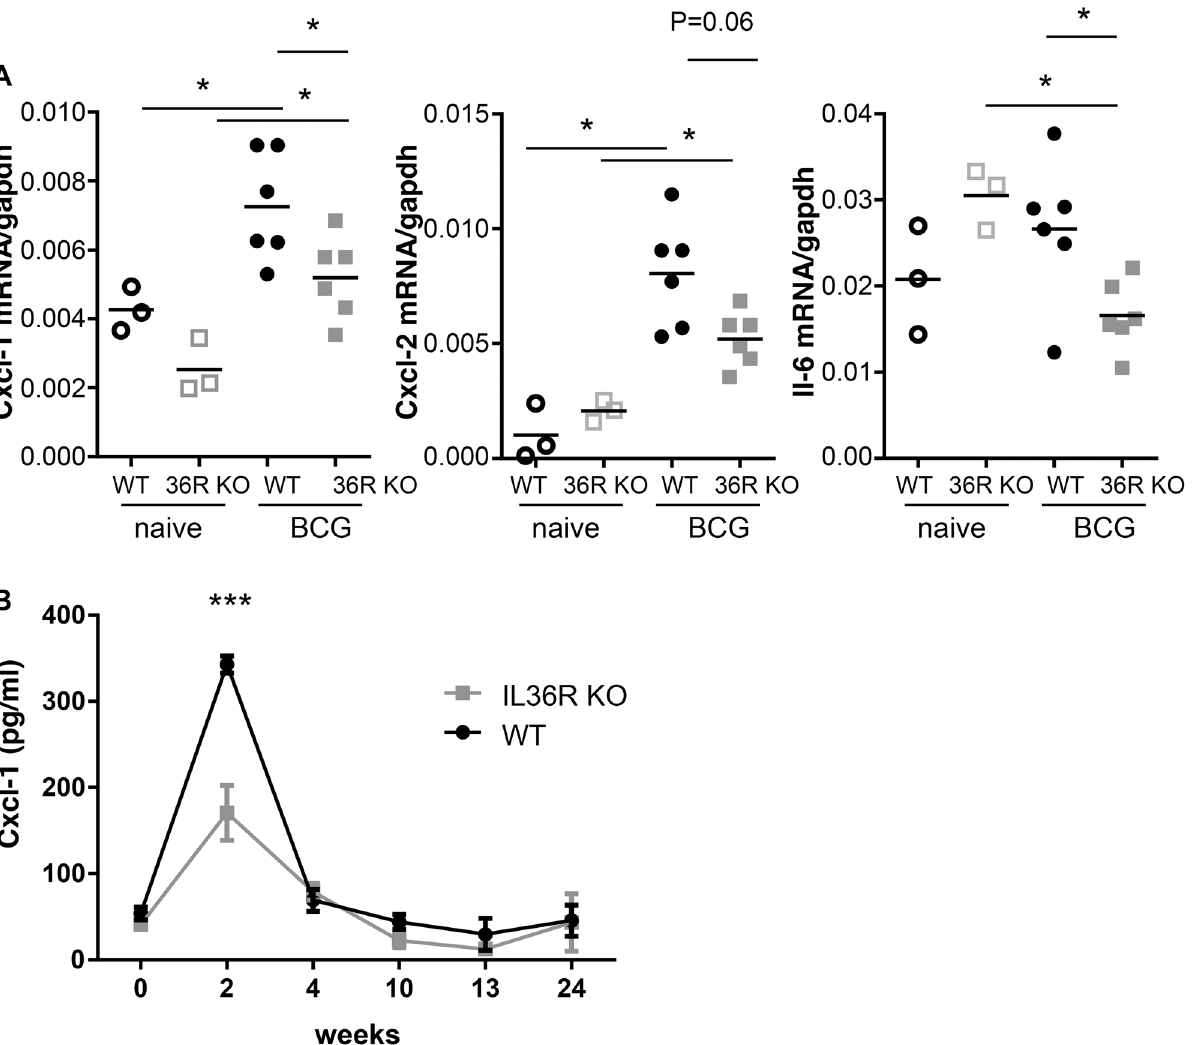
Fig 6. CXCL1 expression in response to M . bovis infection in IL-36R deficient and wild-type mice. A. Total RNA was prepared from the lungs of na ï ve (open symbols) and M . bovis BCG infected (closed symbols) WT (black circles) and IL-36R deficient (grey squares) mice. The results represent Cxcl1 , Cxcl2 , and Il6 mRNA levels determined by RT-qPCR normalized to Gapdh mRNA levels in individual mice. * P < 0.05, as assessed by Kruskal-Wallis, followed by Mann-Whitney test. B. Serum levels of Cxcl1 were measured by ELISA in WT (black symbols) and IL-36R deficient (grey symbols) mice. The results represent means ± SEM of 6 mice per group. Two-way ANOVA for repeated measures, followed by Sidak ’ s multiple comparison test was used to compare IL-36R deficient and WT mice. *** P < 0.001 only at week